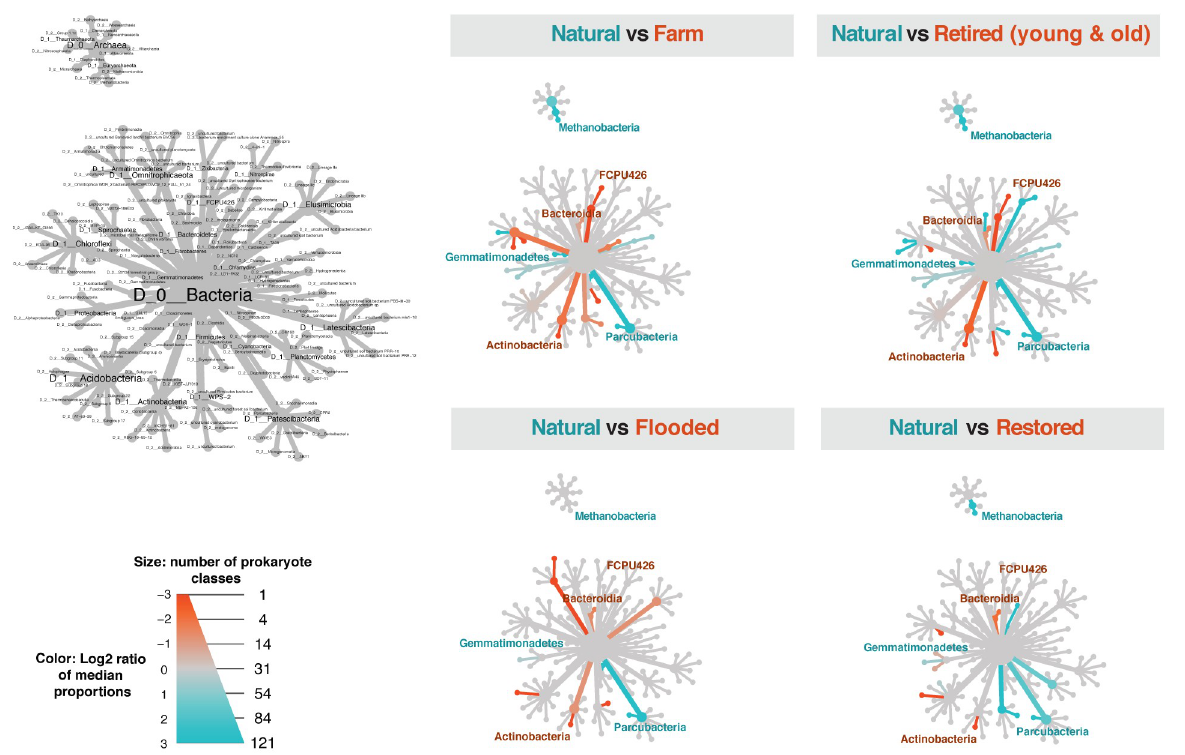
Fig 4. Differences in prokaryotic taxa between treatments and natural wetlands. Heat trees were constructed using the metacoder package [33], at the class taxonomic level. The size of the node in each cladogram is proportional to the number of unique classes within each phylum. Color intensity is proportional to the difference in abundance between natural sites and the other treatments, as calculated from the log2 ratio of median abundance. Young retired and old retired samples were pooled together for simplicity, since they had similar communities. Taxa that have a higher within- sample dominance in natural sites are shown in teal whereas taxa that have a higher within-sample dominance in farm, retired, flooded, and restored wetlands are shown in orange. Nonsignificant comparisons are shown in grey. Colored labels showcase example taxa that were consistently more (teal) or less (orange) abundant in natural sites or displayed variation across the four heat